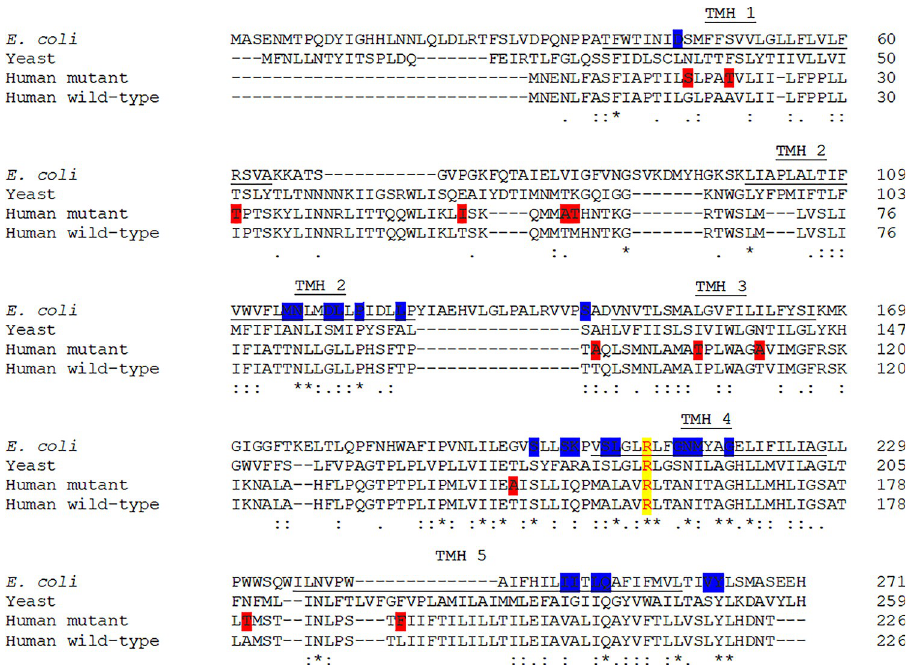
Fig 2. Sequence alignment of MT-ATP-6 (subunit-a). The primary sequence alignment of subunit-a from Escherichia coli , yeast, sequence carrying sequence variations described in this study (red) and human wild-type. The residues predicted to form transmembrane helices 3–5 (TMH3-5) are underlined. The residues shaded blue are important for proton movement. The highly conserved and essential R159 is shaded yellow.